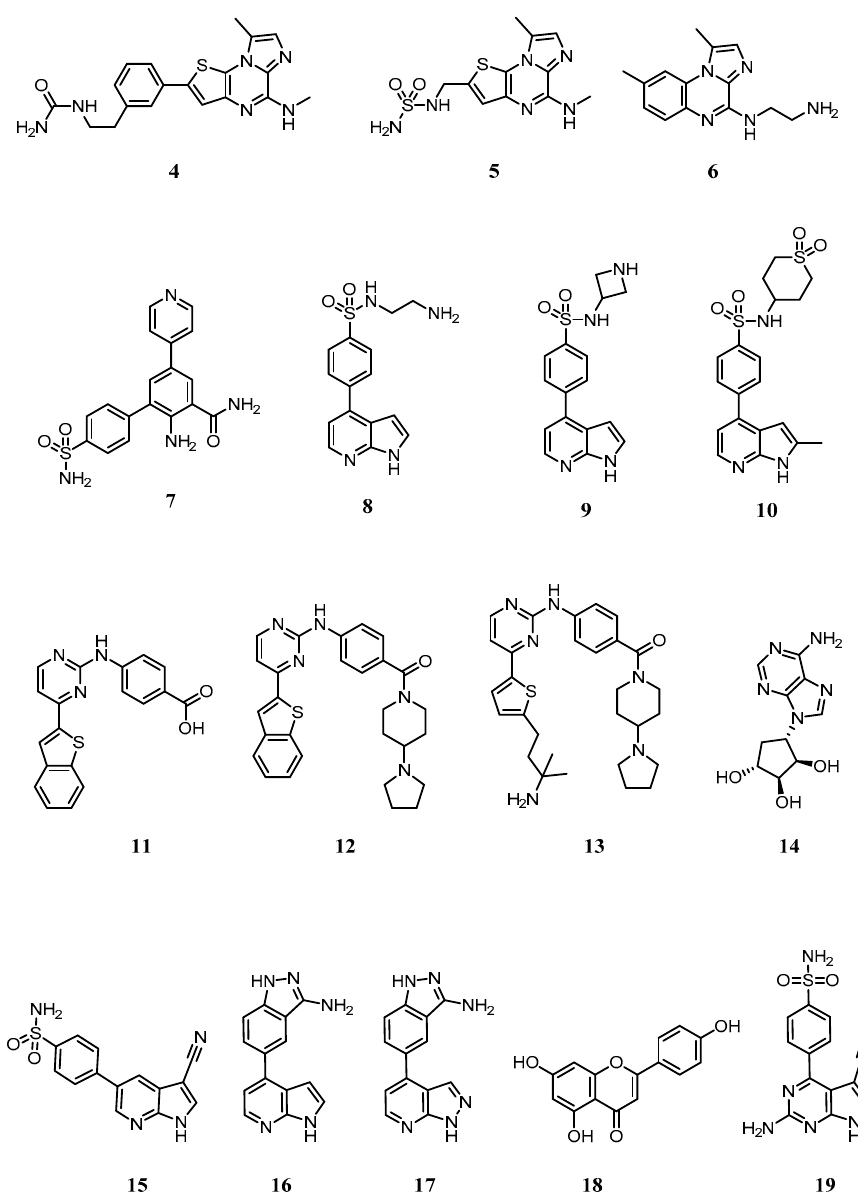
Figure 6. Small molecule dual inhibitors of IKK α and IKK β or selective for IKK α alone. For full chemical names of 4 – 19 see Appendix.